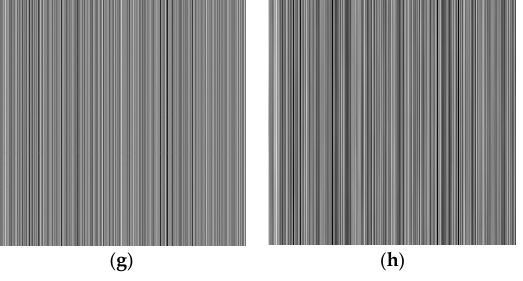
Figure 10. Stripes extracted by various methods. ( a ) Added CFPN; ( b ) WAFT; ( c ) UTV; ( d ) ASSTV; ( e ) VSNR; ( f ) SILR; ( g ) ℓ (cid:2868) sparse; ( h ) LRSUTV.